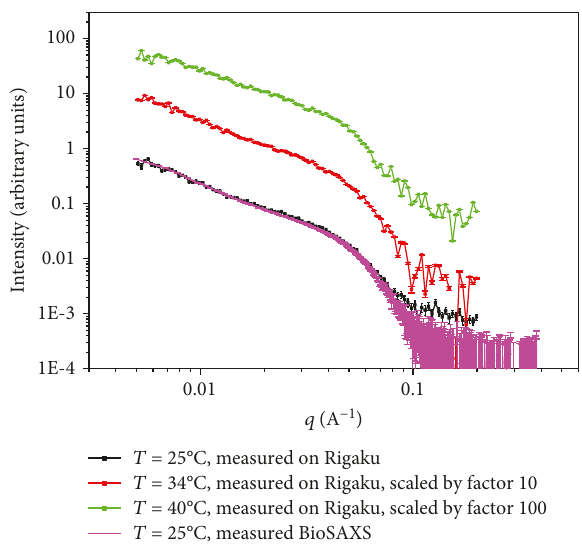
T = 25°C, measured on Rigaku T = 34°C, measured on Rigaku, scaled by factor 10 T = 40°C, measured on Rigaku, scaled by factor 100 T = 25°C, measured BioSAXS Figure 4: SAXS curves, measured at di ff erent temperatures on a Rigaku instrument: black: 25 ° C, red: 34 ° C, and green: 40 ° C. Magenta: SAXS curve, measured with the BioSAXS instrument at ESRF at 25 ° C (added for comparison).